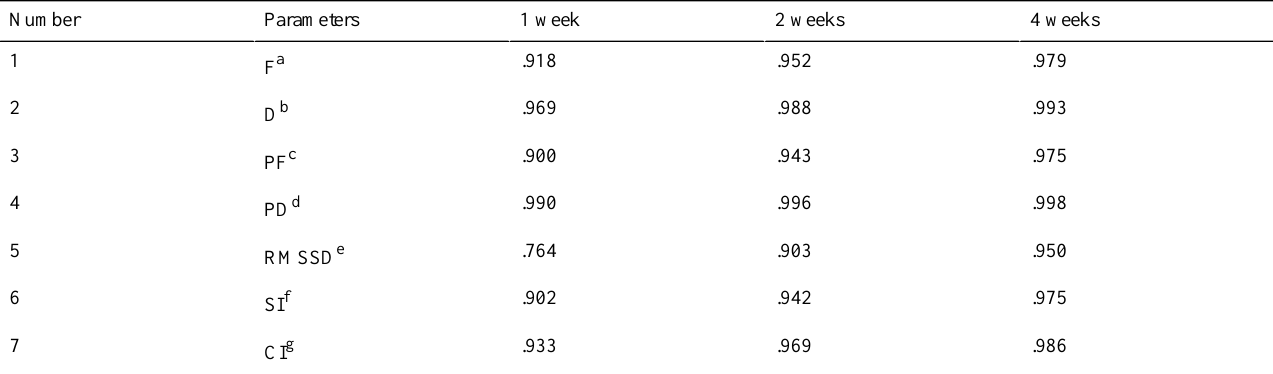
Table 2. The averages of correlations for app-generated parameters between 3 time intervals and 2-month